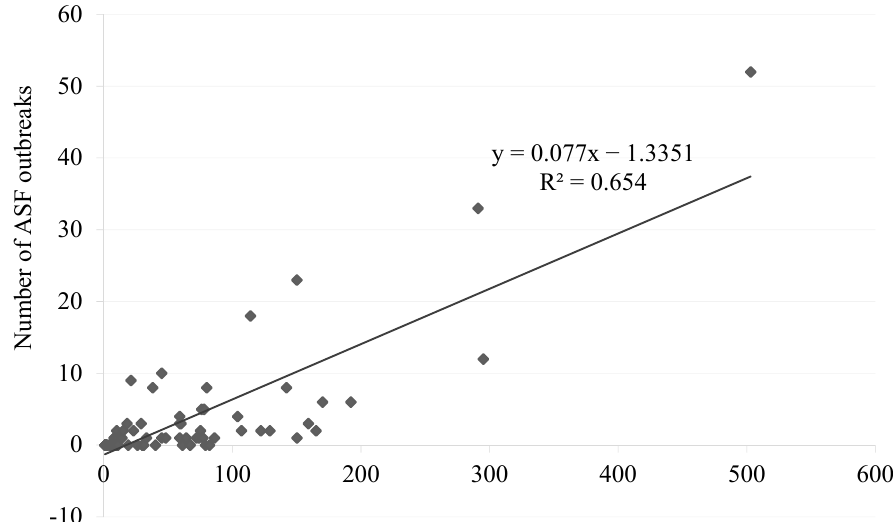
Figure 1. Regression analysis between ASF outbreaks in domestic pigs and ASF cases in wild boars in Poland according to poviats. Source: own study based on CVIF and PKO BP data.